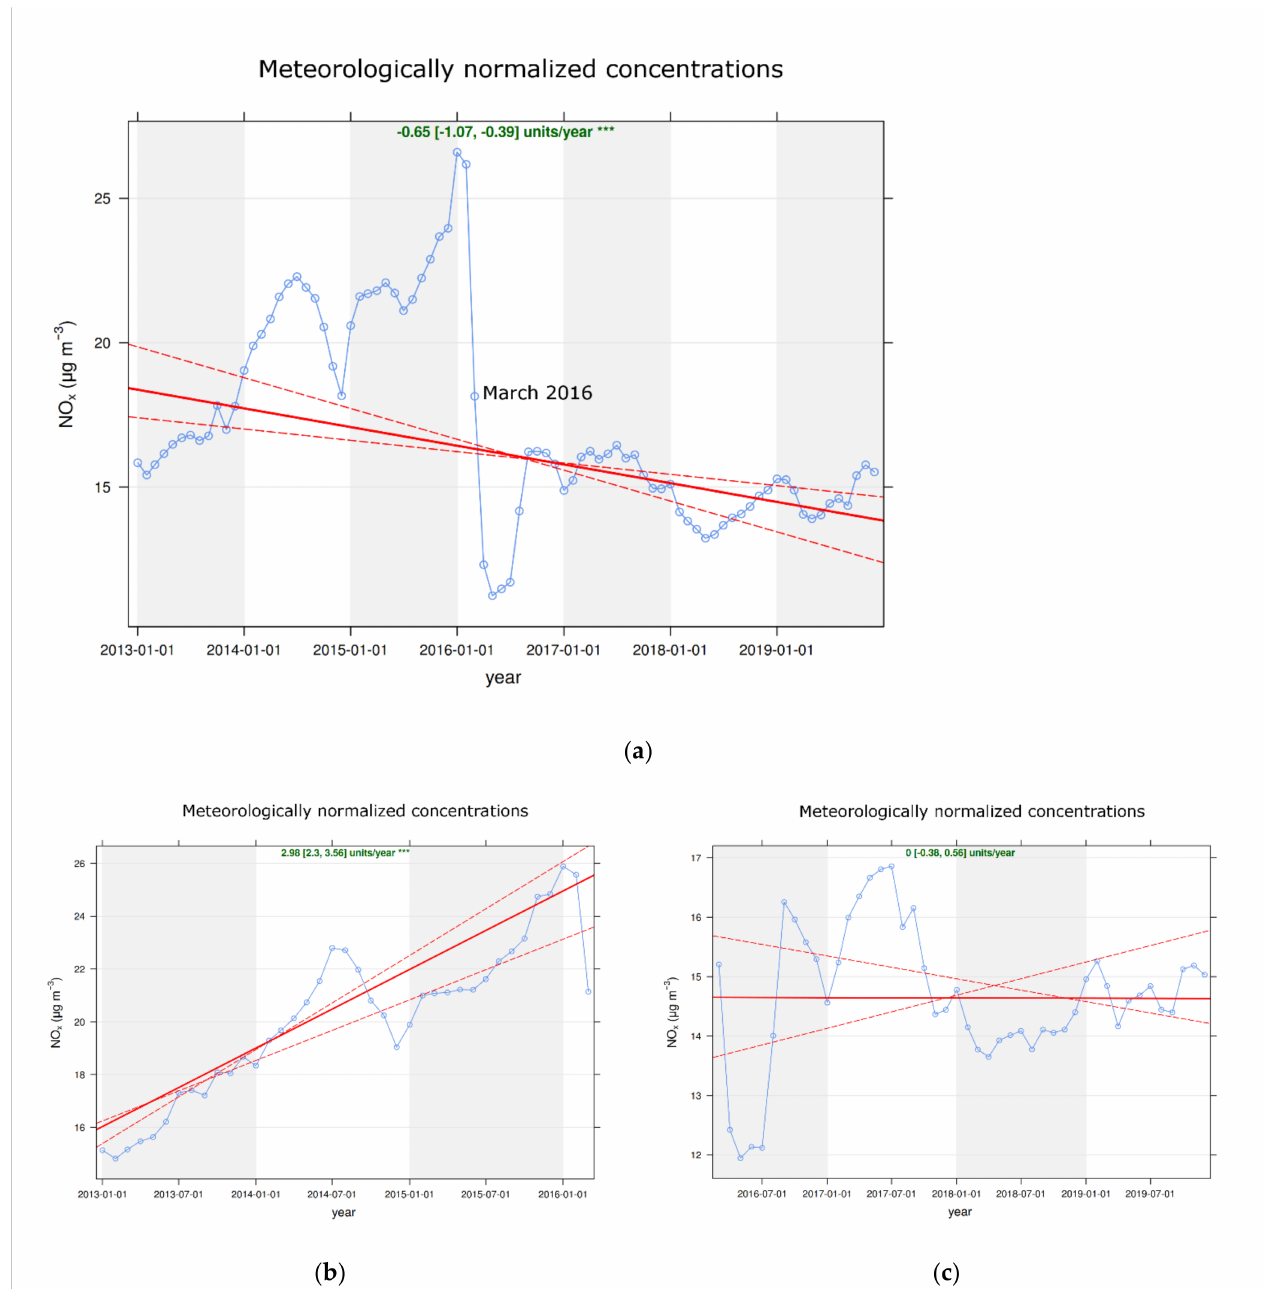
Figure 7. Trend analysis for ( a ) the NO X complete normalized series, ( b ) before and ( c ) after the main change point. Plots show deseasonalized monthly mean concentrations of NO X . Solid red line shows trend estimate and dashed red shows 95% confidence